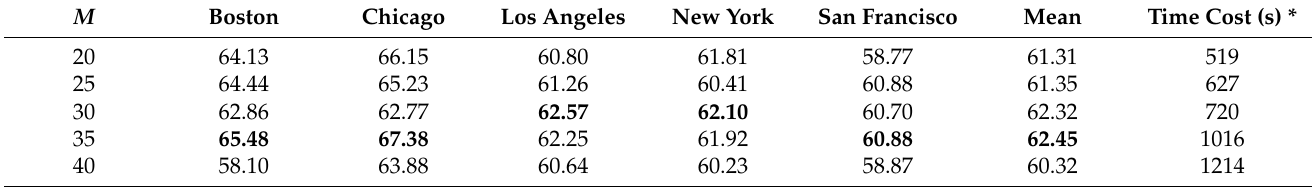
Table 3. The influence of hyperparameter M (number of sentences in each review) on the model classification performance (Accuracy).